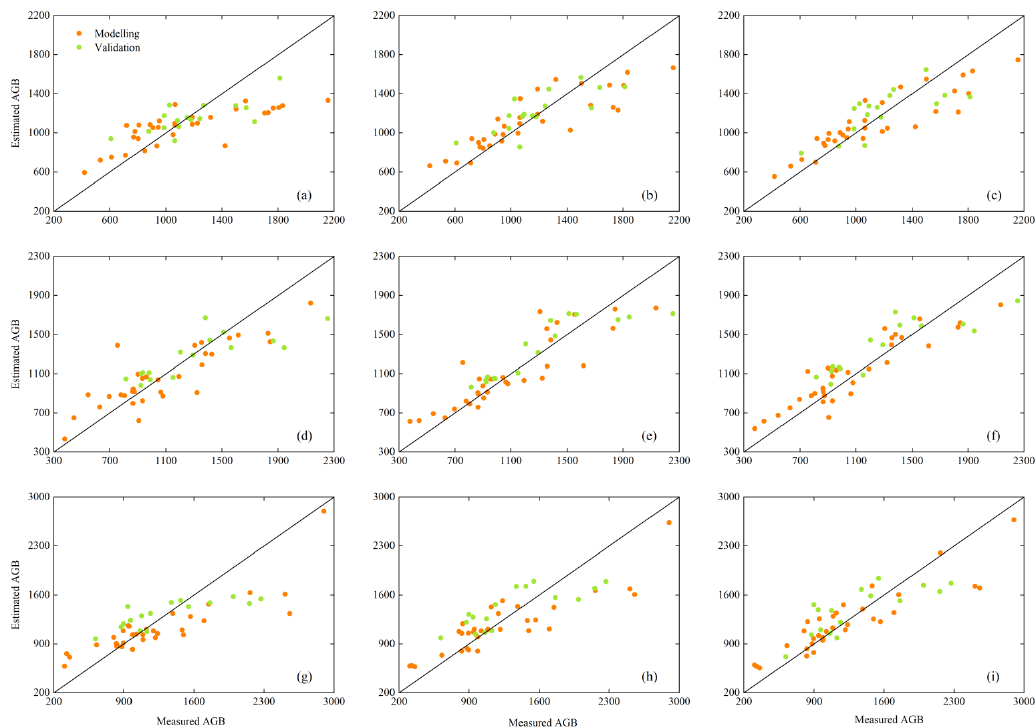
Figure 7. Scatter plots of measured versus estimated potato AGB (kg/hm 2 ) for modeling and valida- tion datasets at different growth stages based on spectral information combined with CH and using SVM, RF, and GPR methods. ( a ) – ( c ) Relationship between measured and estimated potato AGB for the tuber-formation stage, as per SVM, RF, and GPR methods, respectively. ( d ) – ( f ) Same as panels